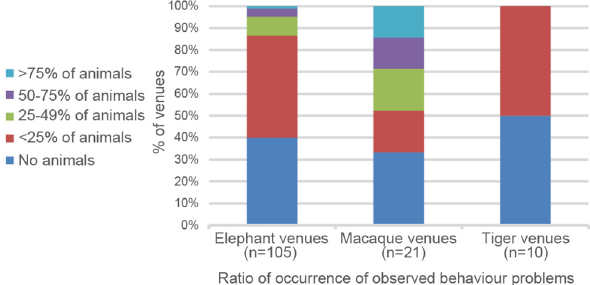
Fig 3. Occurrence of behaviour problems at each assessed venues. The percentage of animals with observed behavioural problems at each venue and the number of these venues give a rough estimate of the frequency of behavioural problems, such as stereotypic behaviour. Care must be taken in interpreting these findings as observations were only possible during the relatively short time frame of the visits to each